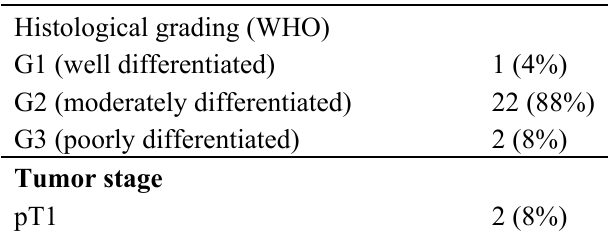
Table 2. Tumor characteristics.